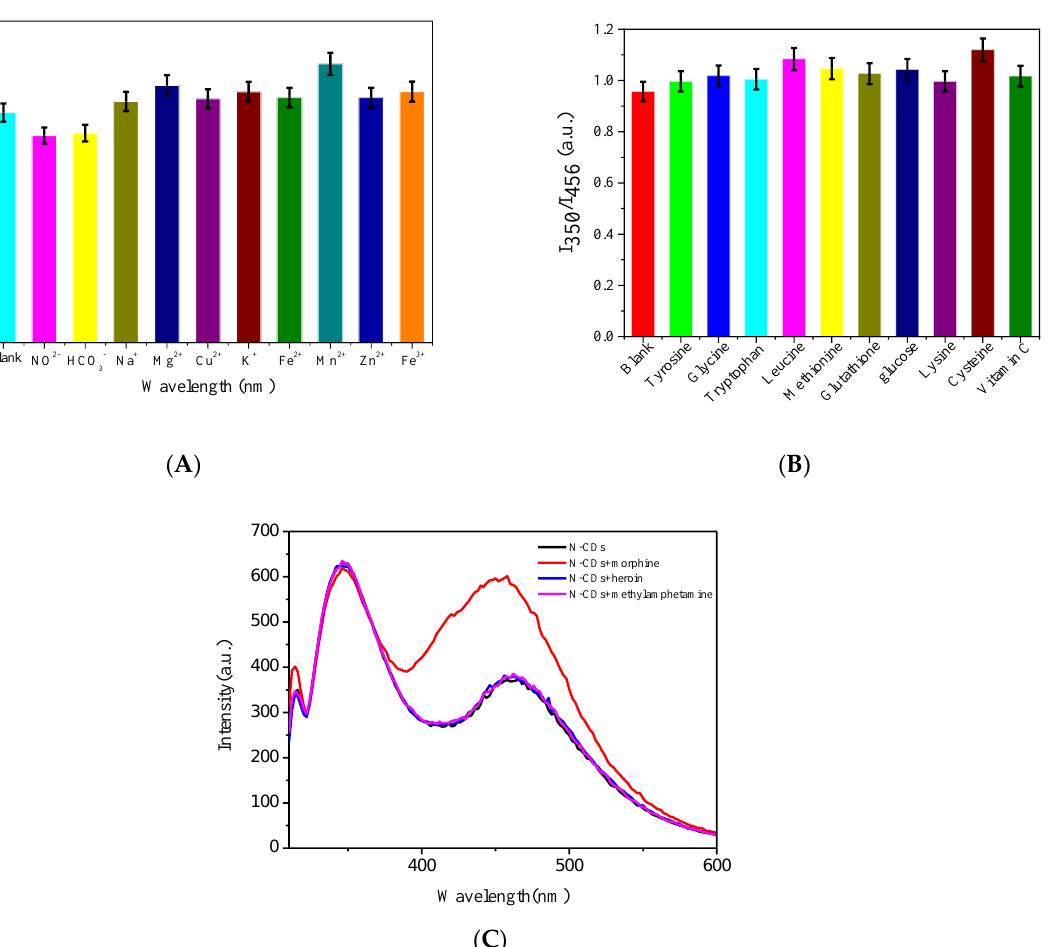
Figure 6. Effect of ( A ) interfering ions and ( B ) interfering substances under the same conditions (pH: 8.0; system temperature: 44 °C; N-CDs: 100 μL; MOR concentration: 10 μg/mL; Ex: 310 nm; Em: 350 nm and 456 nm) (n = 3); ( C ) fluorescence spectra of MOR and its analogues (pH: 8.0; system temperature: 44 °C; N-CDs: 100 µL; concentration of MOR and its analogues: 10 μg/mL).